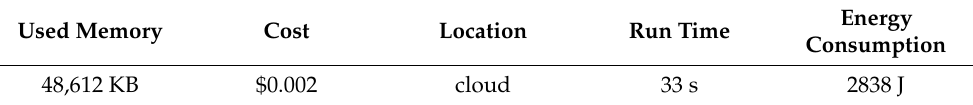
Table 8. Task ID 108145